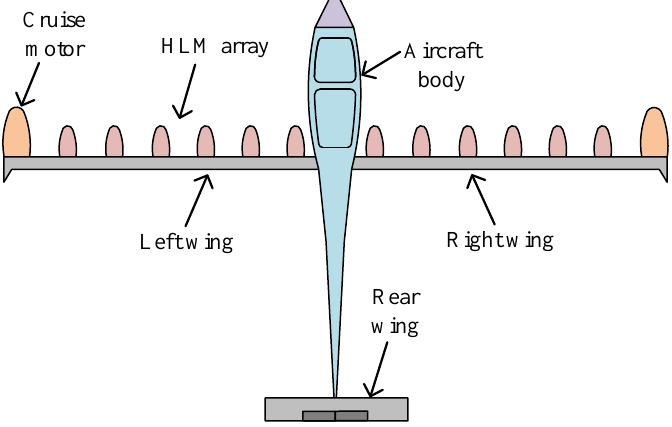
Figure 1. Top view of the NASA Maxwell X-57 distributed propulsion aircraft [19].